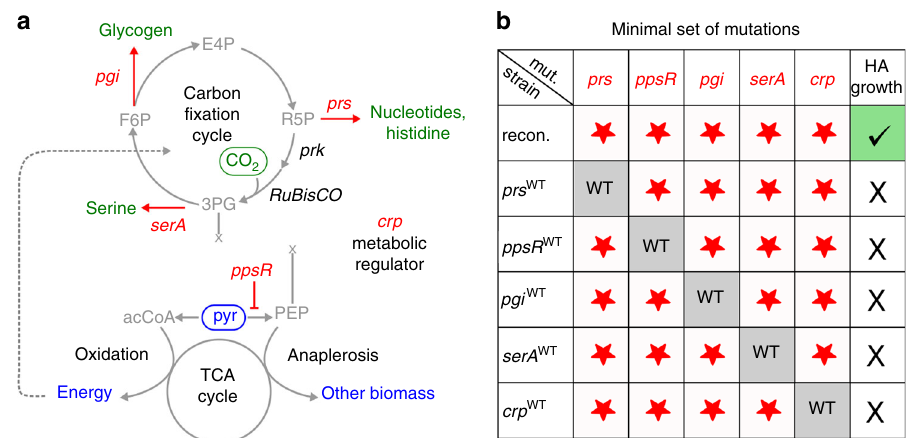
Fig. 2 A locally minimal set of mutations enables hemiautotrophic growth. a Role of mutated genes (red) in central carbon metabolism. Three mutations are located in branch points of the synthetic CBB cycle ( serA ;H210Q, pgi ;G378C, and prs ;R105_A110dup). Two mutations are regulators in fl uencing the carbon metabolism ( crp ;M190K and Δ ppsR ). The initial strain design decouples central carbon metabolism in order to create two distinct modules, one for energy production and second for CO 2 fi xation. In green, biomass components originating from CO 2 ; in blue, end products of pyruvate supply. Ovals mark the feed substrates. b The reconstructed strain has fi ve essential mutations that enable CO 2 fi xation. Reverting every mutation independently back to WT prevents hemiautotrophic growth on liquid media, showing that this set of mutations is suf fi cient and